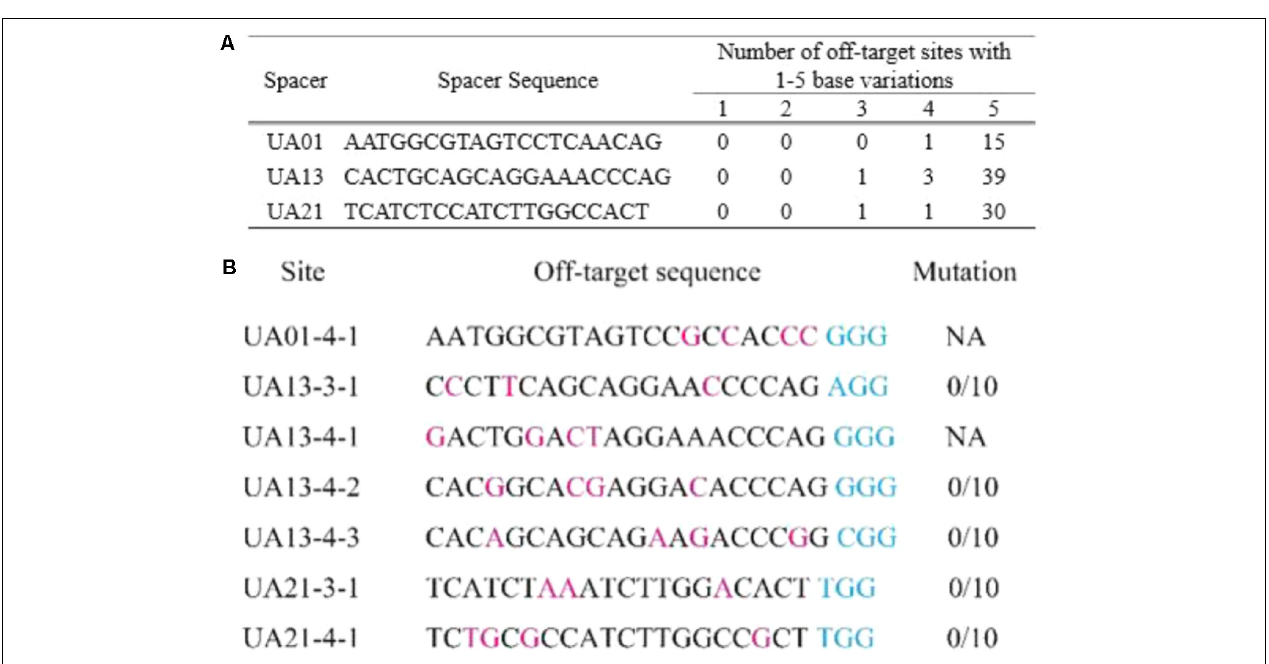
FIGURE 3 | The predicted off-targets of three USTA gRNA spacers. (A) The sequences of three USTA gRNA spacers and numbers of their off-targets with 1–5 nucleotide differences. The off-target sites of gRNA spacers UA01, UA13, and UA21 were predicted with the Cas9off program. All of them have no off-targets with only one or two nucleotide variations. Spacer UA01 has only one off-target with four nucleotide variations. (B) Sequences of the off-targets of with fewer than five nucleotide variations from USTA gRNA spacers and experimental verification results. Nucleotides in the off-targets differing from the gRNA sequences are in pink. The PAM sequences (NGG) are in blue. For each gRNA spacer, the off-target sites were amplified and sequenced from 10 corresponding ustA deletion mutants. No mutations were detected in any of the 10 ustA mutants (0/10) at UA13-3-1, UA13-4-2, UA13-4-3, UA21-3-1, and UA21-4-1. NA, no data available due to PCR